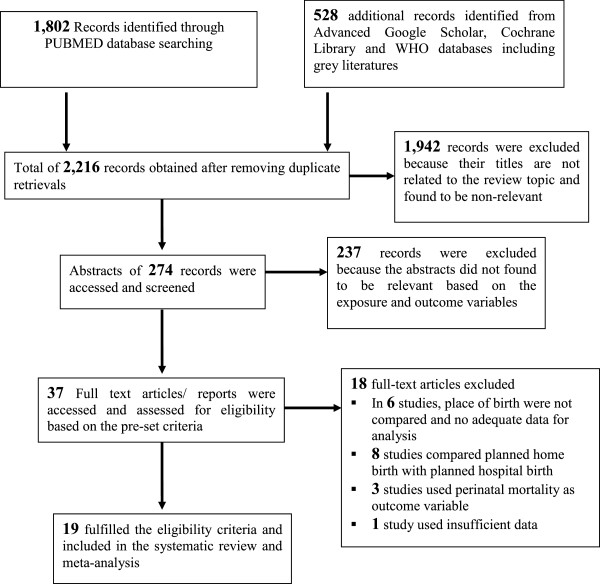
Flow chart showing the procedure of selecting studies for the systematic review and meta-analysis, 1988-2012.